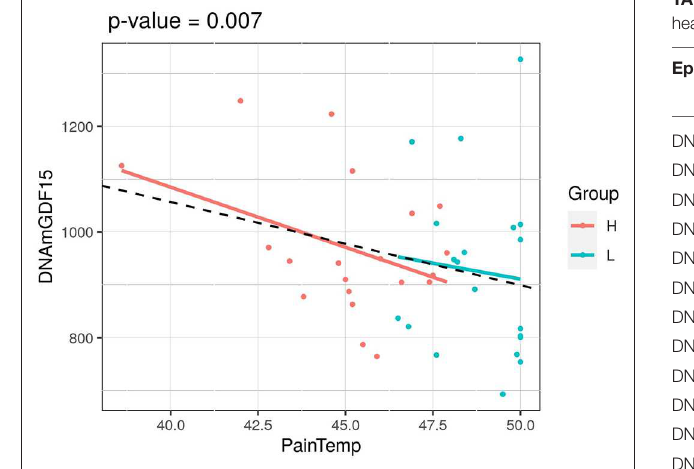
TABLE 4 | Results of statistical hypothesis testing comparing FM patients and healthy individuals (HC), using the MLR approach correcting for chronological age.